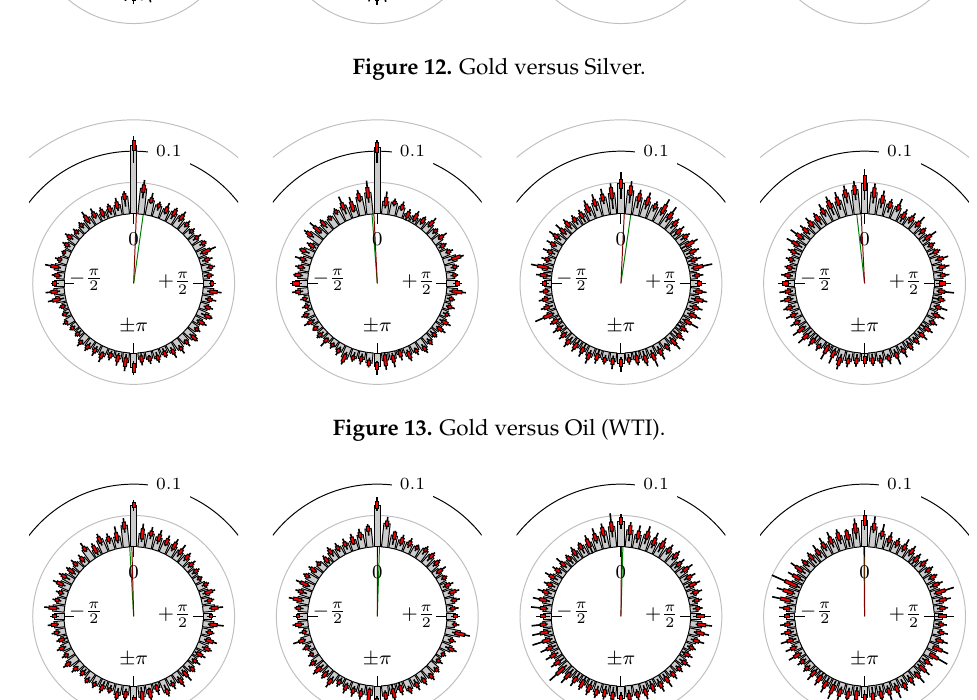
Figure 12. Gold versus Silver.